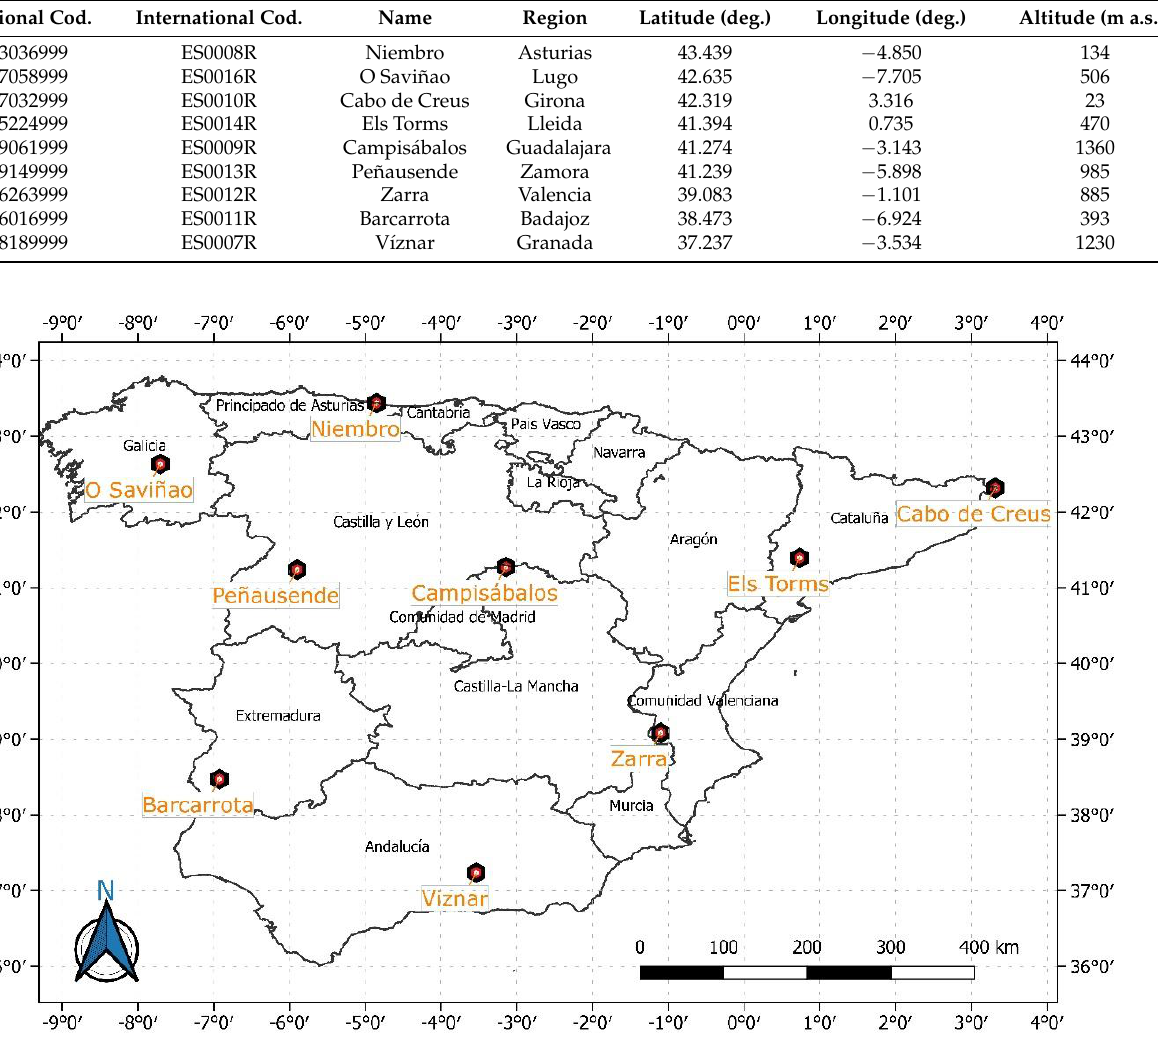
Figure 1. Location of the background stations used in the study. Administrative boundaries ’ layer retrieved from IGN (https://www.ign.es/web/rcc-info-delimitaciones (accessed on 1 September 2022)) and modified through